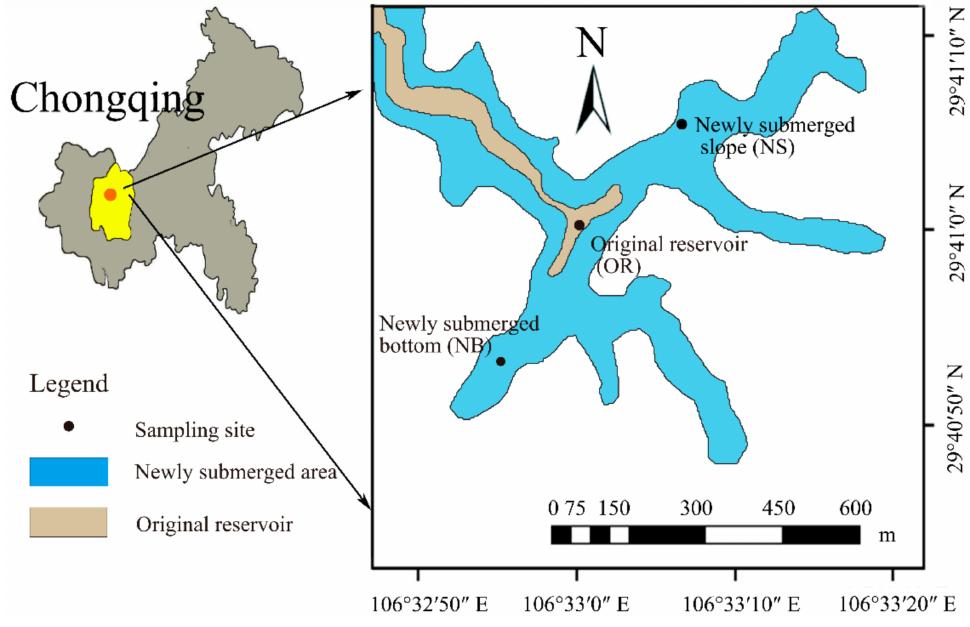
Figure 1. Locations of three sampling sites in